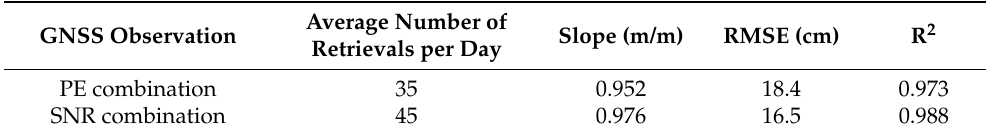
Table 5. The average number of retrieval points per day, slope of regression line, RMSE, and correlation for both PE combination and SNR combination methods.